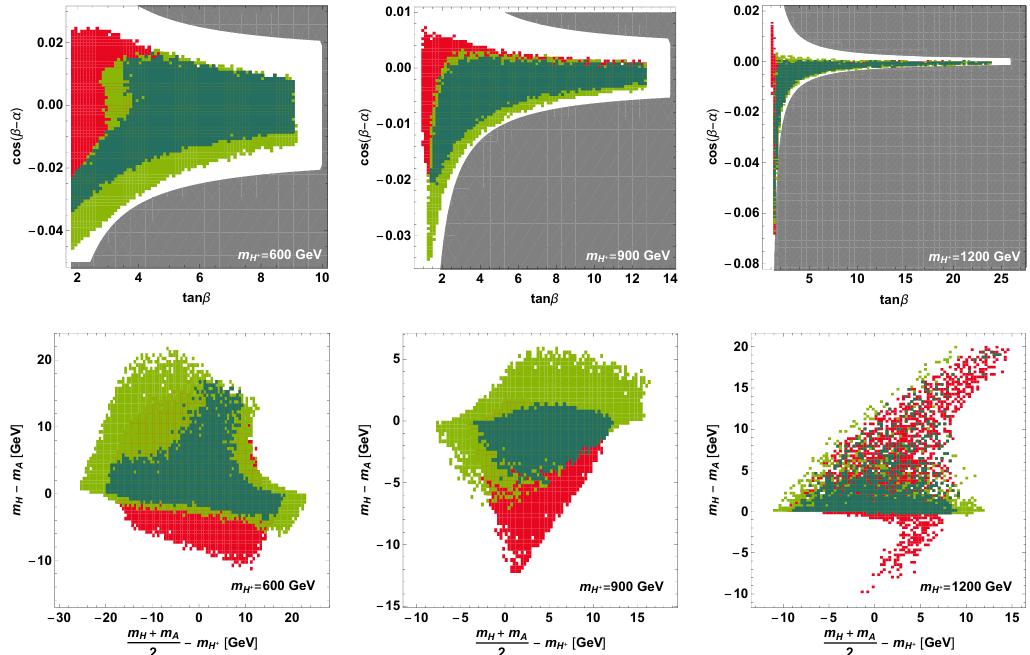
Figure 5 . The detail views of the parameter regions inside the white dashed lines in (cid:12)gure 4. The masked region is shaded with gray. All the points satisfy the low energy constraints and remain perturbative until the Planck scale. The red points satisfy the bounded-from-below constraint. The lighter green points satisfy the vacuum stability constraint. The darker green points satisfy both of